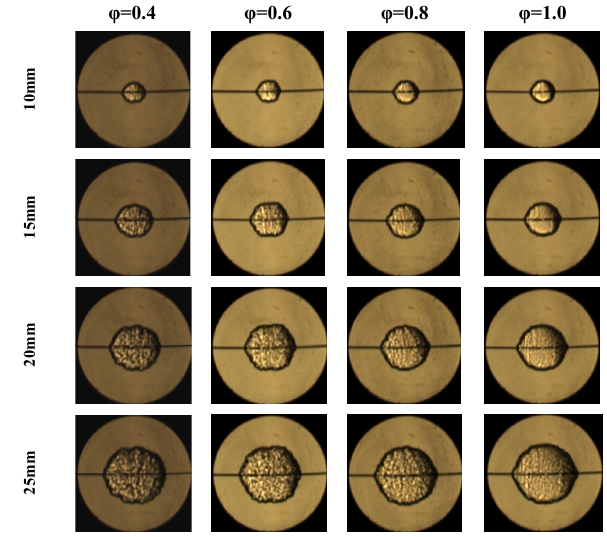
Figure 7. Schlieren pictures for flames of 80%H ratios for different